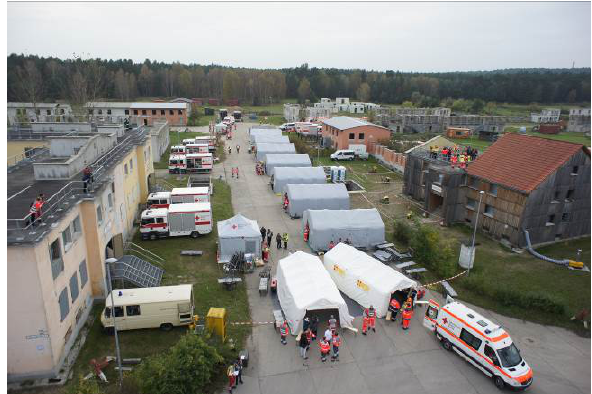
Figure 10: Image of the treatment area during the exercise acquired by a